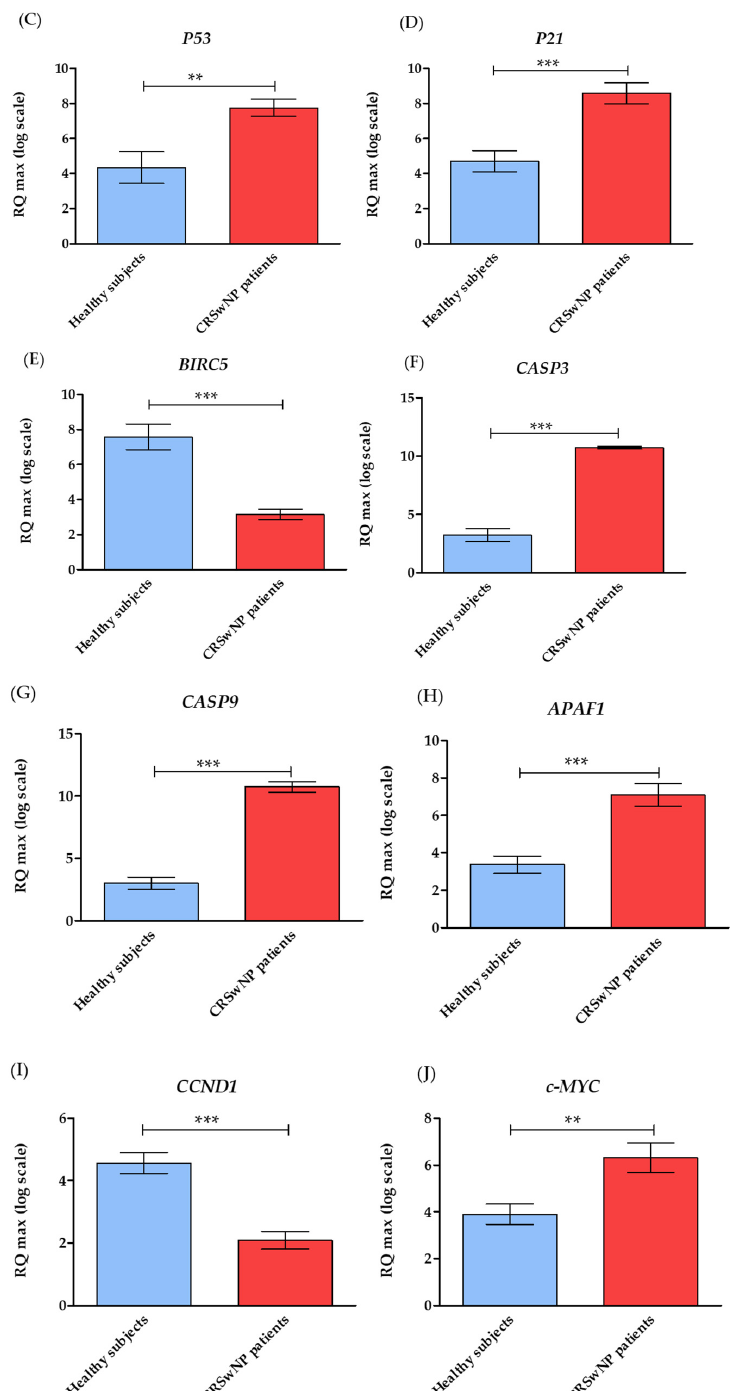
Figure 2. The expression profile of genes was associated with apoptosis and cell survival. Transcript levels were established for CRSwNP patients to the healthy subjects. The following markers at mRNA were detected: BAX —apoptosis regulator BCL2 Associated X ( A ); BCL-2 —B-cell CLL/lymphoma 2 ( B ); P53 —Tumor Protein P53 ( C ); P21 —cyclin-dependent kinase inhibitor 1A ( D ); BIRC5 —Baculoviral IAP repeat-containing protein 5 ( E ); CASP3 —Caspase 3 ( F ); CASP9 —Caspase 9 ( G ); APAF1 —Apoptotic protease-activating factor 1 ( H ); CCND1—G1/S-specific cyclin-D1 ( I ); cMYC —Myc proto-oncogene protein ( J ). The average fold change of the target genes was determined in relation to the housekeeping gene, i.e., glyceraldehyde 3-phosphate dehydrogenase (GAPDH). Statistically, significant differences are indicated with an asterisk. Statistically significant differences were noted at p < 0.01 (**), and p < 0.001